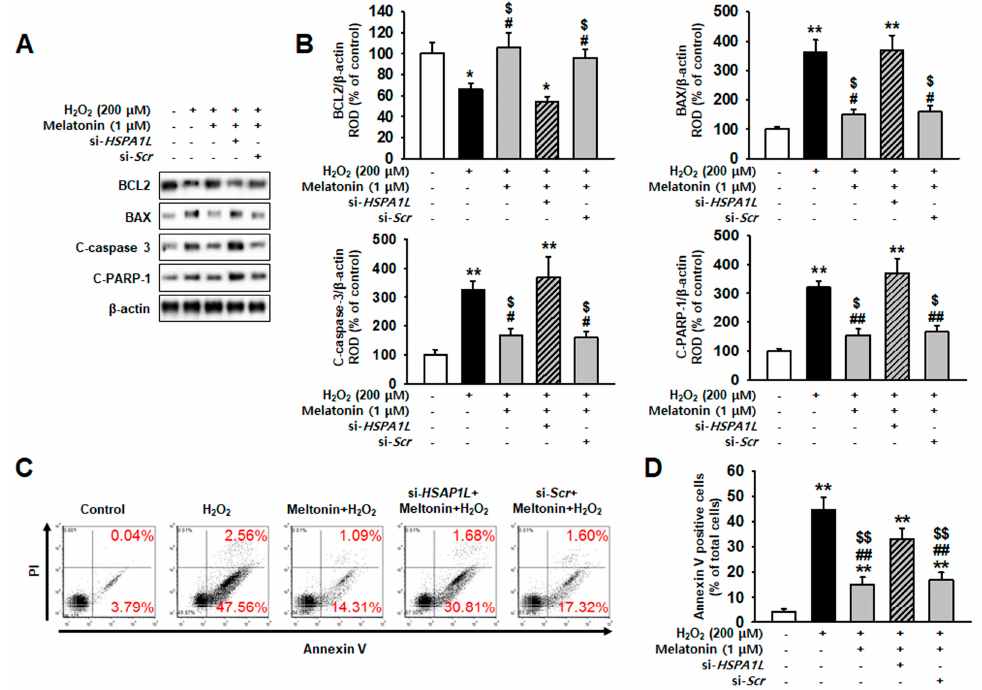
Figure 6. Melatonin protects against oxidative stress by preserving the stability of parkin. ( A ) Expression of anti-apoptotic protein BCL2, and pro-apoptotic proteins BAX, C-caspase-3, and C-PARP-1, in hMSCs treated with melatonin (1 µ M, 24 h) and HSPA1L siRNA (si- HSPA1L ) ( B ) Expression levels were normalized relative to those of β -actin. Values represent the mean ± SEM. * p < 0.05, and ** p < 0.01 vs. untreated hMSCs, # p < 0.05, and ## p < 0.01 vs. H 2 O 2 -treated hMSCs, $ p < 0.05 vs. melatonin-treated hMSCs pretreated with si- HSPA1L . ( C ) hMSCs were pre-treated with melatonin (1 µ M, 24 h) and si- HSPA1L , and subjected to oxidative stress. Untreated hMSCs were subjected to oxidative stress only. ( D ) All groups were assayed using PI-Annexin V, and Annexin V-positive hMSCs were quantified using FACS. Values represent the mean ± SEM. ** p < 0.01 vs. untreated hMSCs, ## p < 0.01